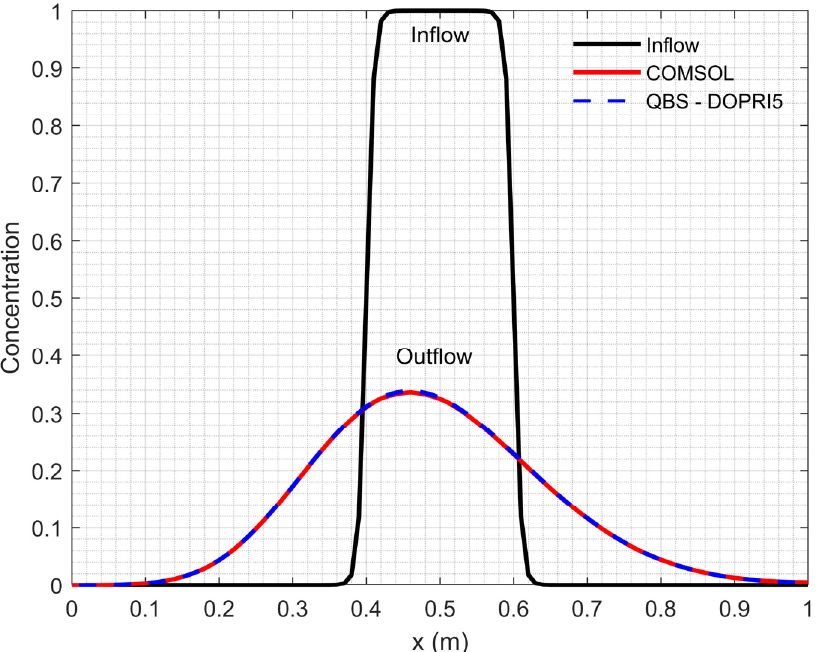
Figure 10. Concentration profiles at the inlet and outlet boundary at time 1.7 days for Scenario A.